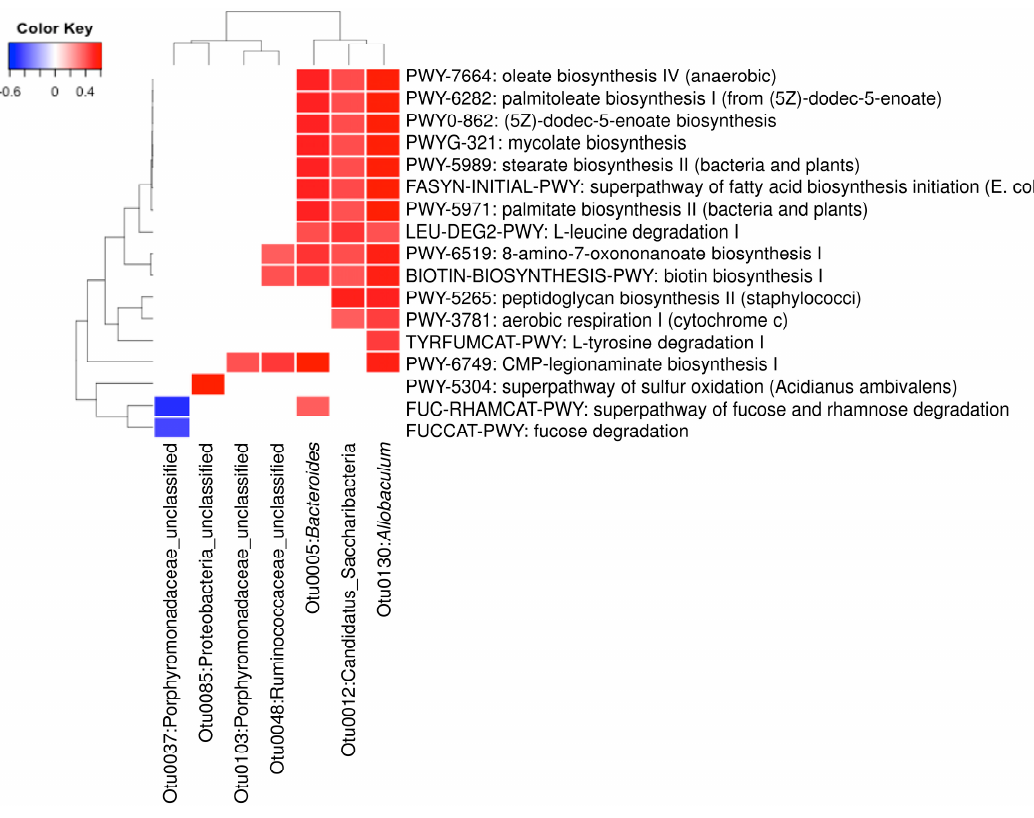
Figure 8. Heatmap analysis of operational taxonomic units (OTUs) associated with the predicted metabolic pathways shifted by DML extracts ( p < 0.01).